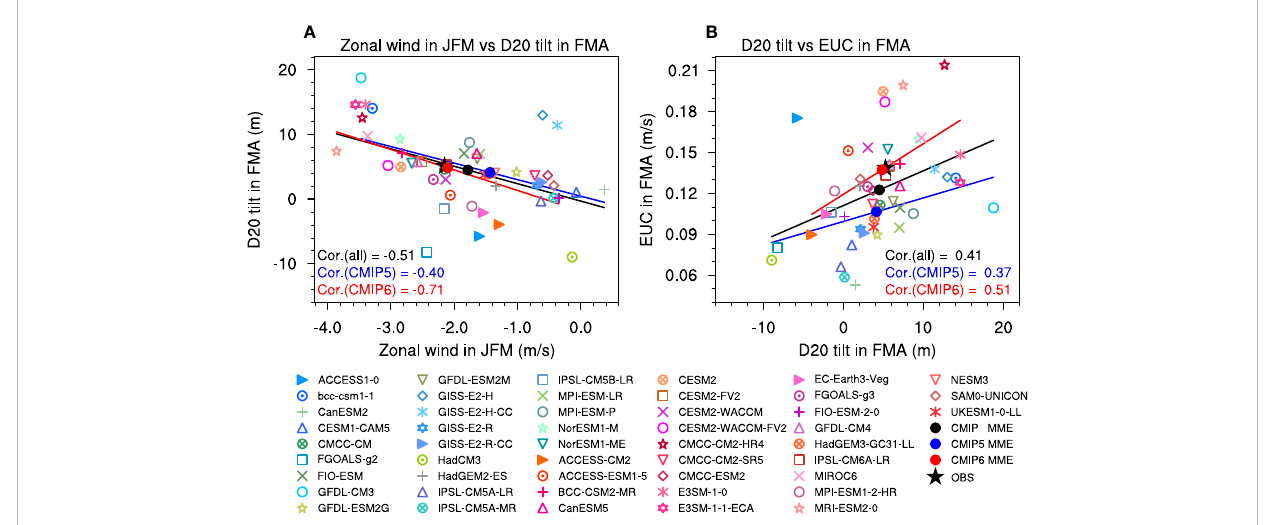
FIGURE 6 Scatterplots of (A) the JFM mean 925-hPa zonal wind averaged over the region (2° S – 2° N, 50 – 80° E) versus the FMA mean D20 tilt (2° S – 2° N, 50 – 70° E minus 70 – 90° E), and (B) the FMA mean equatorial D20 tilt vs the FMA EUC in CMIP5 and CMIP6 models. The black, blue, and red solid lines denote the best- fi t line for all the CMIP models, the CMIP5 models, and the CMIP6 models, respectively, based on linear regression. The intermodel correlation coef fi cients for all the CMIP models (black font), the CMIP5 models (blue font), and the CMIP6 models (red font) are shown underneath each